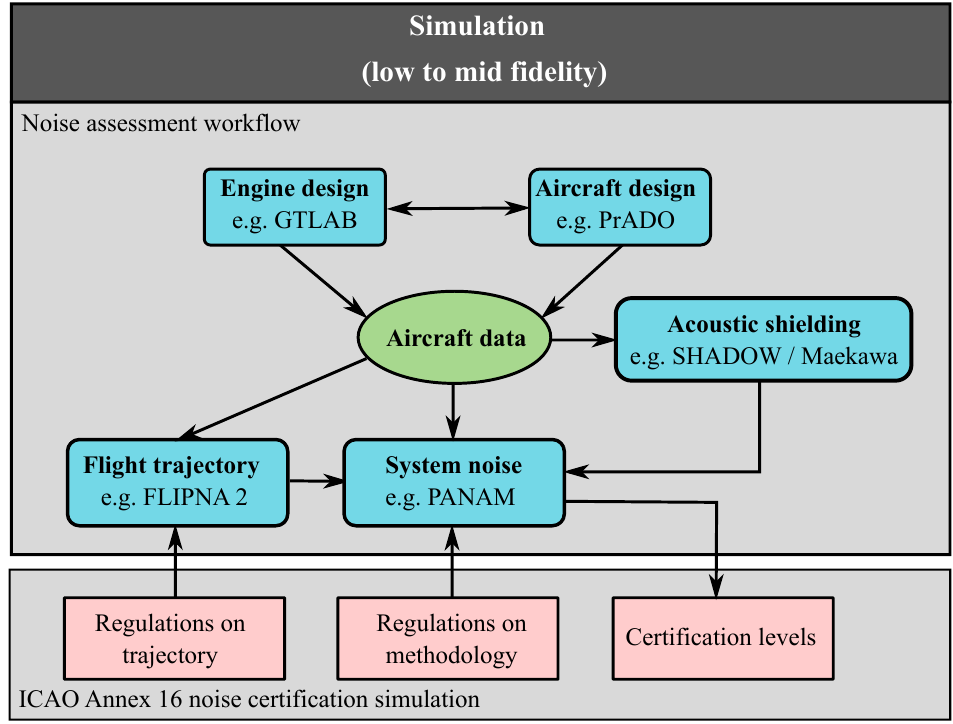
Figure 3. Schematic of the developed process for automated virtual noise